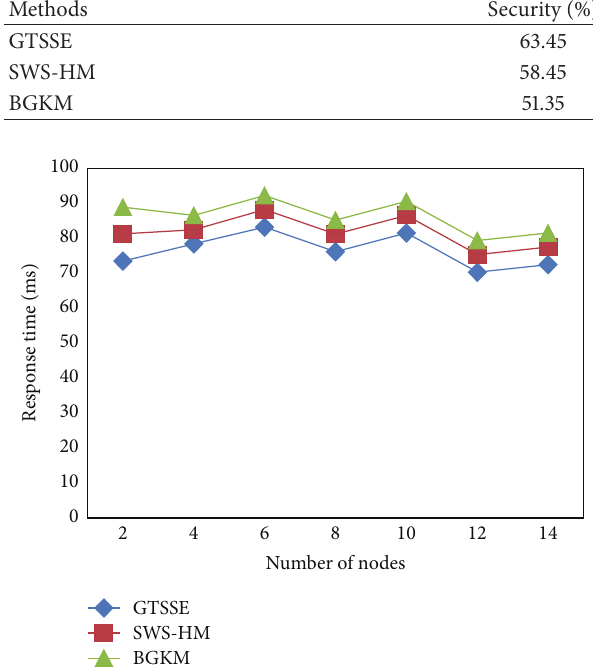
Table 3: Response time comparison in WBAN using GTSSE, SWS- HM, and BGKM.